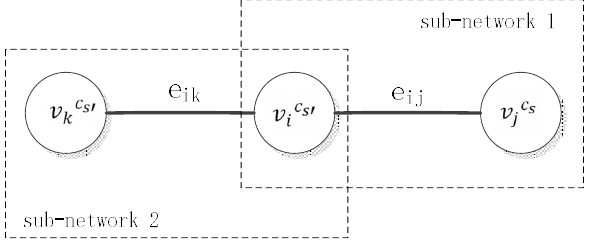
Figure 1. A simple example of the heterogeneous network.